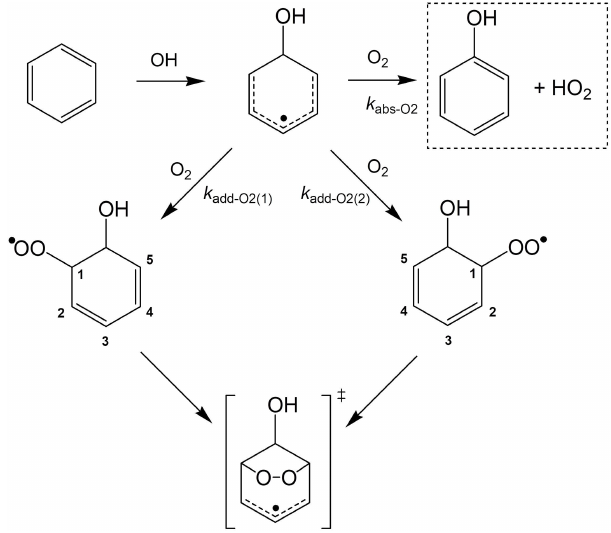
Figure 3. Schematic representation of the reaction of OH-aromatic adducts with O 2 , with alkyl substituents omitted for clarity. The abstraction pathway (for which the rate coefficient is k abs-O quires the presence of an α -H atom, and is therefore unavailable for adducts formed from OH addition ipso to an alkyl group. The rate coefficients for the two addition pathways ( k add-O k add-O ) depend on the number and distribution of alkyl sub- 2 ( 2 ) stituents at positions 1 to 5 (see Sect. 4.1 and Table 8). The resultant β -hydroxy cyclohexadienylperoxy radicals are assumed to undergo prompt ring closure to produce a common “peroxide-bicyclic” rad-